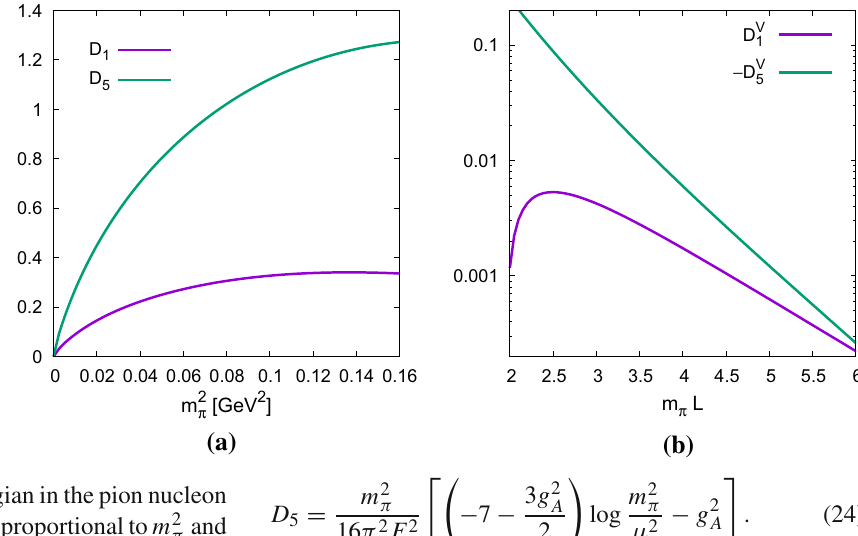
Fig. 3 The numerical results of the pure loop contributions. a The infinite volume correction of (24). b The finite